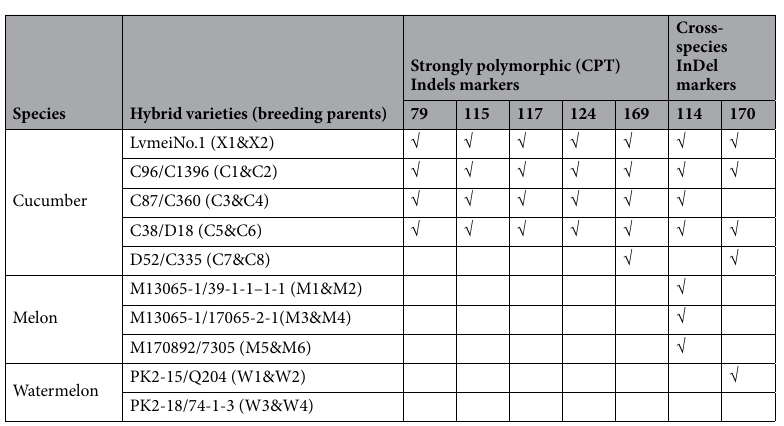
Table 4. Polymorphism information of cross-parents and cross-species transferable InDel